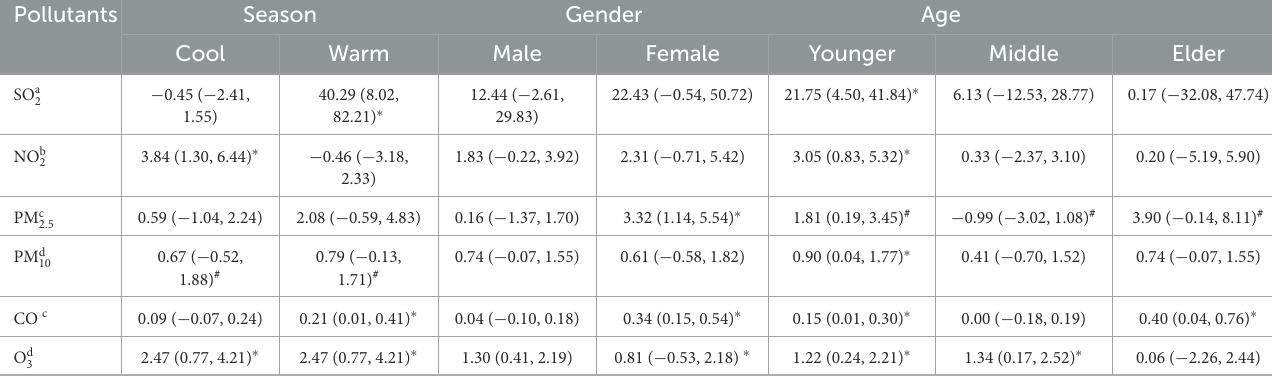
TABLE 2 Percent change (95% CI) in urolithiasis EDVs with a 10 µ g/m 3 increase in air pollutant concentrations by season, gender and age in Wuhan, China. Pollutants Season Gender Age Cool Warm Male Female Younger Middle